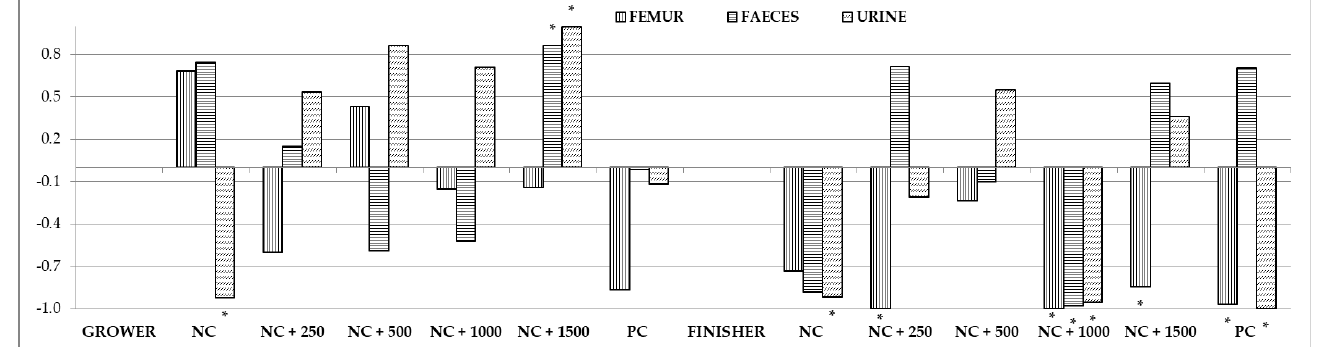
Figure 2. Correlations between content of phosphorus in the blood and in the femur, feces, and urine. Asterisks indicate significant correlations at p < 0.05.